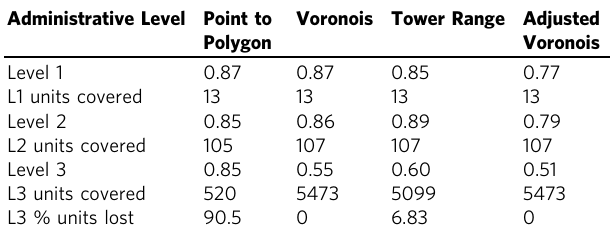
Table 4 Results of the second Kendall ’ s tau-b rank test, comparing the order in which administrative units are ranked by census-based population density fi gures against how the same units are ranked using user density fi gures derived from each CDR distribution method — only using administrative units covered by the corresponding distribution